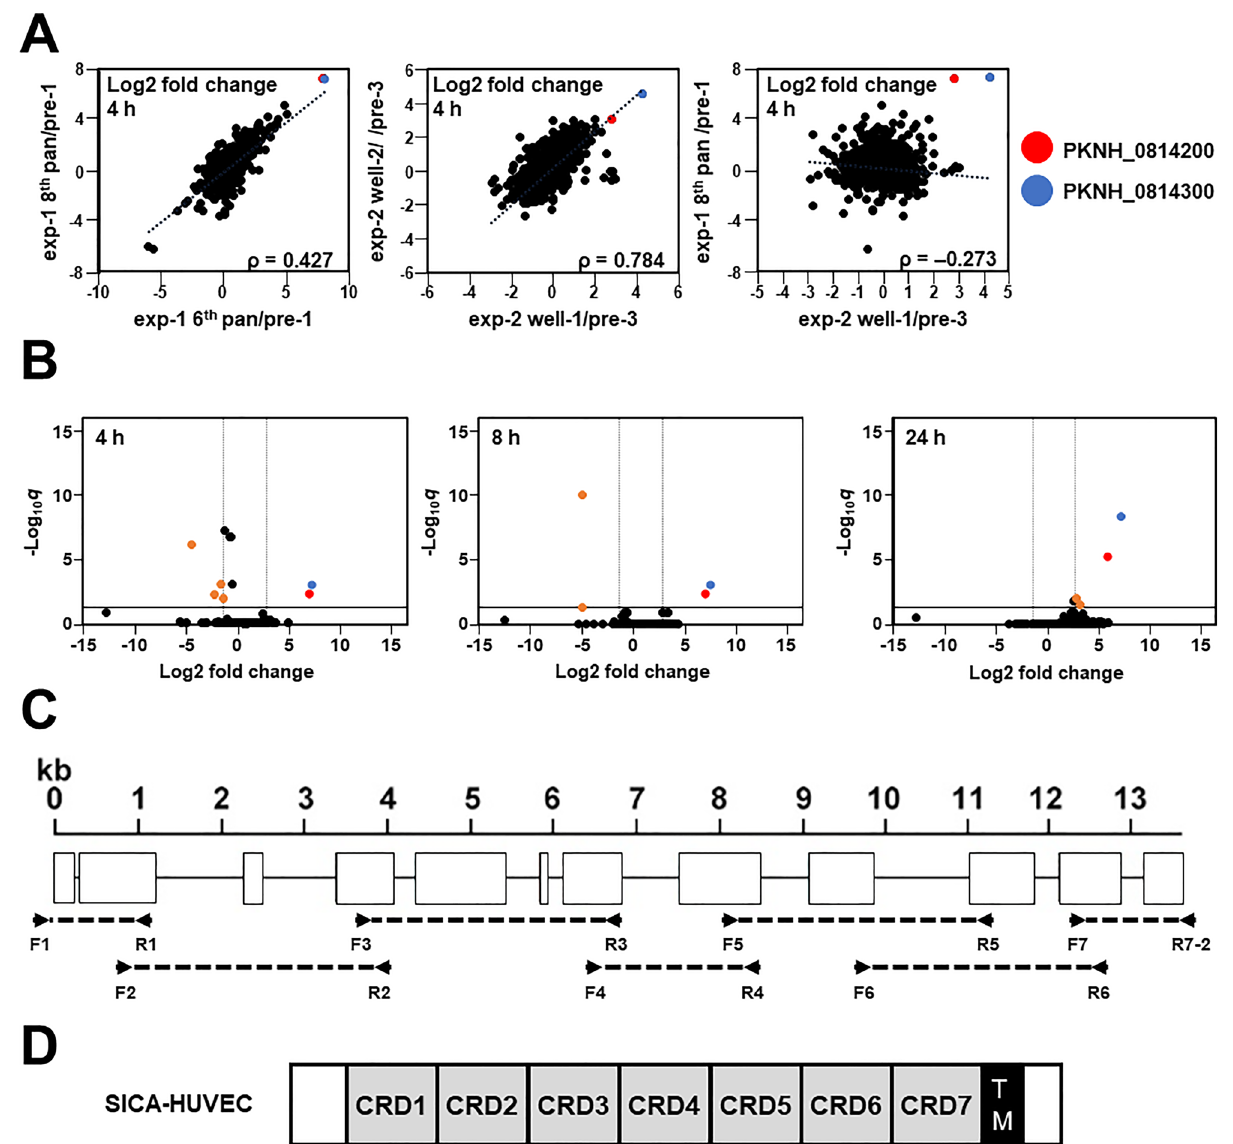
Figure 2. RNA-seq data analysis of cytoadherent and wild-type P. knowlesi . ( A ) Correlation of the fold change of the transcript levels between samples at 4 h after RBC invasion. The coordinate axes show log2 fold changes of transcript amounts by panning selection of the 6th and 8th pans of exp-1 (left), wells 1 and 2 samples of exp-2 13th pan (middle), and samples after the 8th pan of exp-1 and well-1 of exp-2 13th pan (right). Spearman’s rank correlation coefficients (ρ) are shown. ( B ) Volcano plots showing log2 fold changes of transcript amounts by panning selection plotted against the − log 10 of q value obtained by the comparison between non-binding control samples (pre-1, -2, and -3) and binding parasites samples (8th pan of exp-1, wells 1 and 2 of exp-2 13th pan) at three different time points. The dashed and solid lines indicate absolute log2 fold change = 2 and q = 0.05, respectively. Genes significantly differentially expressed ( q < 0.05) and at least fourfold changed are shown in orange dots. Genes with non-significant differences or less than fourfold changed are shown in black dots. Gene fragments of PKNH_0814200 and PKNH_0814300 are highlighted in red and blue, respectively. ( C ) A schematic depiction of the sica-huvec exon–intron structure, which contains 12 exons. Locations are indicated for the primers used to amplify the fragments to determine the cDNA sequence. ( D ) Predicted domains of SICA-HUVEC. CRD, cysteine-rich domain; TM, transmembrane domain. The size is not to